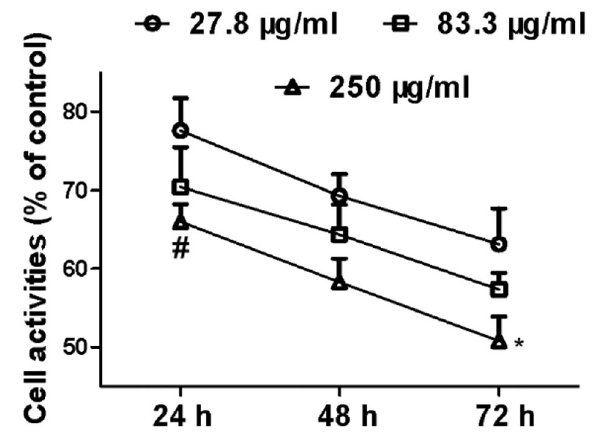
FIGURE 3 | SCIP inhibits the proliferation of MCF-7 cells. Cells were synchronized and incubated with SCIP at various concentrations (27.8, 83.3, and 250 µ g/ml) for 24, 48, and 72h, respectively. Then, the cell samples were harvested and subjected to investigate the proliferation of MCF-7 cells by MTT analysis. Each value was expressed as mean ± SD for three independent experiments by GraphPad Prism Software Version 5.0. * p < 0.05 was considered a significant difference when compared with 24h, and # p < 0.05 was considered a significant difference compared to the low dose